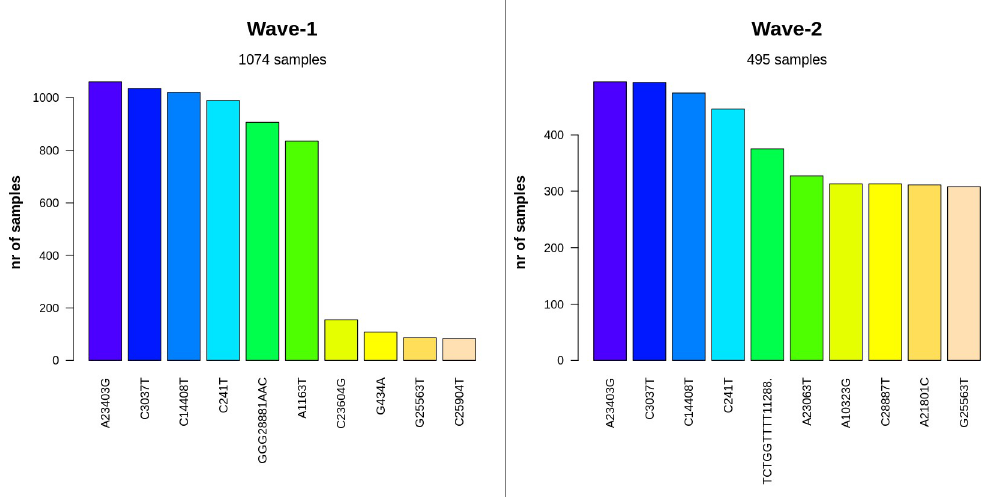
Fig 5. Most frequent mutations at the nucleotide level in wave-1 and wave-2. The first four nucleotide events were the most widespread for both waves in Bangladesh. Among them, A23403G, C3037T, and C241T mutations are characteristic features of G clade and its derivatives. Wave-2 showed a substantial frequency of the TCTGGTTTT oligonucleotide deletion at 11288